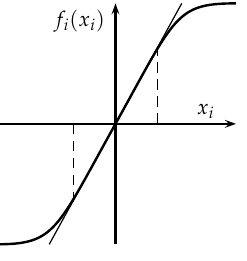
Figure 16. Configuration employed for f i ( x i )